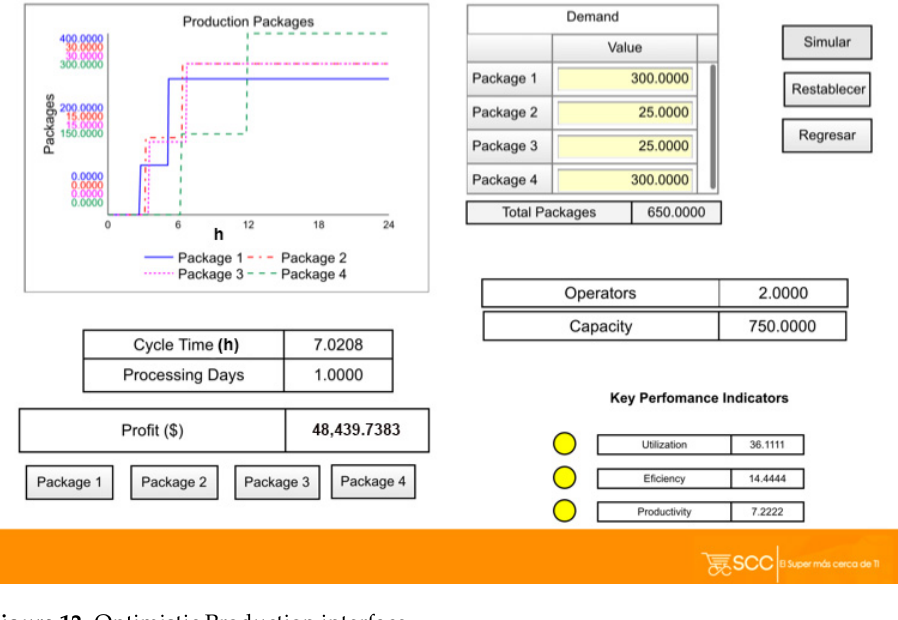
Figure 12. Optimistic Production interface.